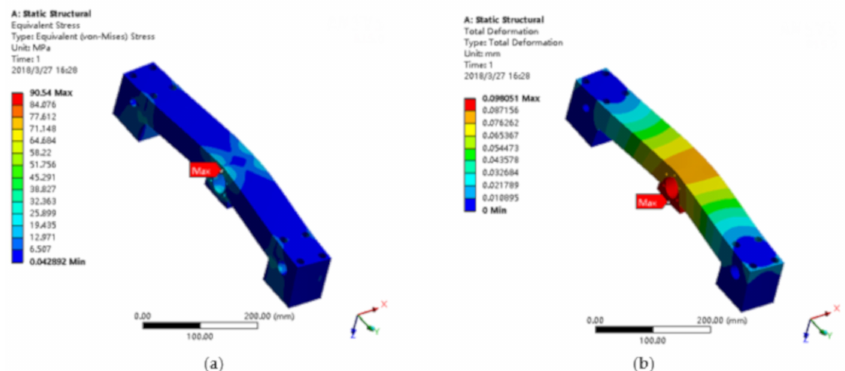
Figure 12. ( a ) Stress distribution and ( b ) deformation distribution of the knockout